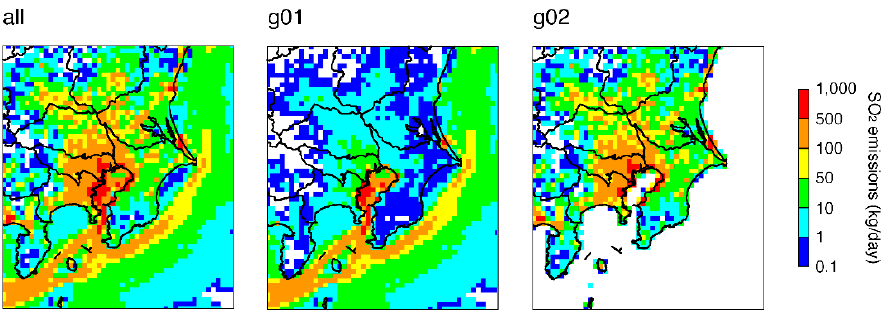
Figure 6. Spatial distribution of ( left ) all SO 2 emission sources used in this study and SO 2 emissions from sources g01 ( center ) and g02 ( right ) over domain 4. Note that emissions are shown in two dimensions and most of g01 is distributed on the surface layer of the model, whereas g02 is distributed over the upper layer of the model, considering the stack heights.